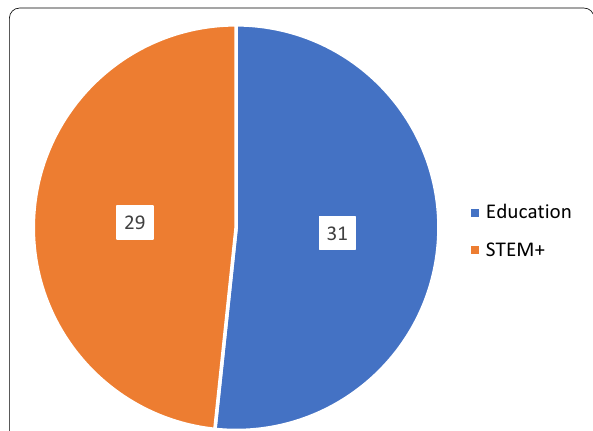
Fig. 8 Publication distribution by the corresponding